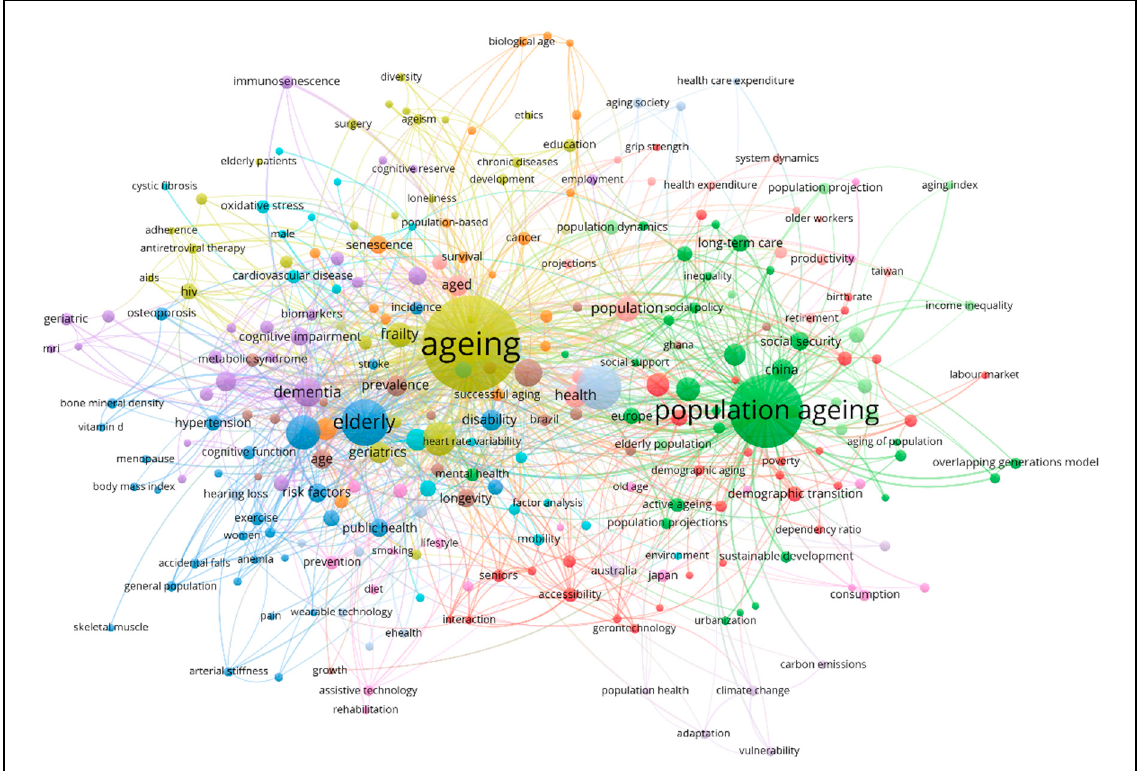
Figure 6. Network visualization map of author keywords.